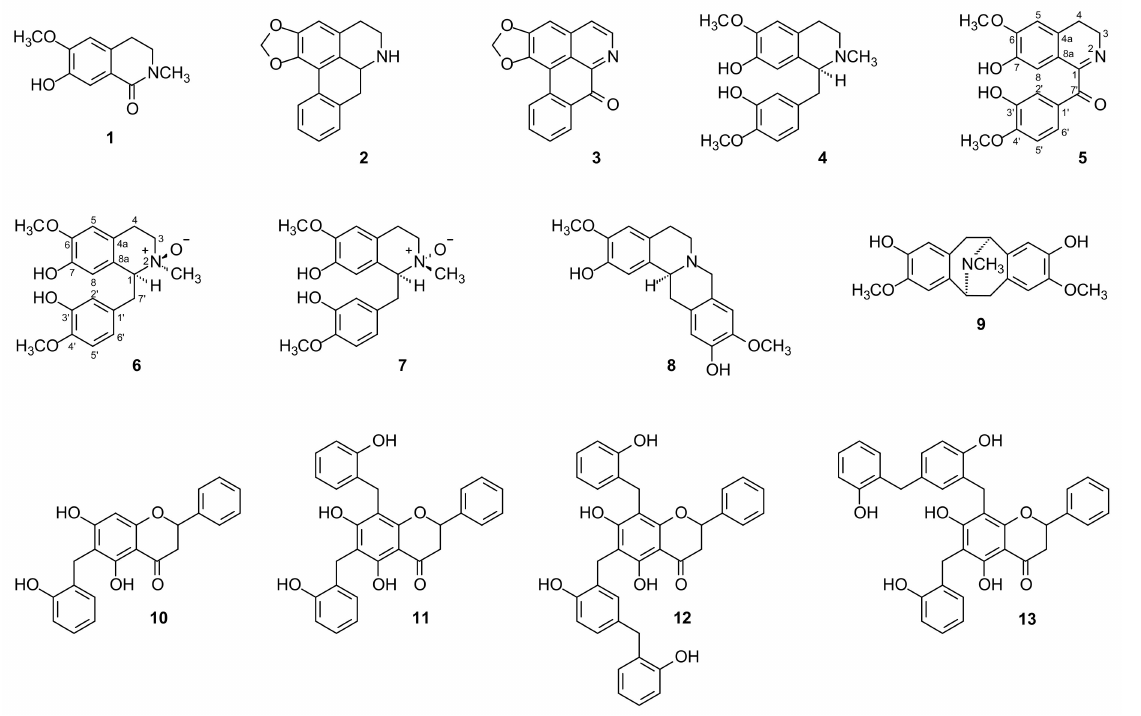
Figure 1. Chemical structures of the isolated compounds from the bark of D. calycina . Compound 5 was obtained as a brown amorphous powder and tested positive for Dragendorff’s reagent. It showed a protonated molecule at m/z 328 [M + H] + in the LR- ESI (+)MS compatible with the molecular formula C 18 H 17 NO 5 . The 1 H and 13 C-NMR spectra of 5 (Table 1) were consistent with those of reticuline ( 4 ) [27], except for the absence of the nitrogen-bonded methyl group (CH 3 − N ) and the signal of the methine group in position 1, which was replaced by a signal at δ C 165.1 in the typical 13 C-NMR spectrum of the imine group conjugated to a carbonyl group at δ C 192.8. In the 1 H-NMR spectrum, three downfield hydrogens at δ H 6.88 (1H, d, J = 8.4 Hz, H-5 (cid:48) ), δ H 7.57 (1H, d, J = 2.0 Hz, H-2 (cid:48) ) and δ H 7.60 (1H, dd, J = 8.4 and 2.0 Hz, H-6 (cid:48) ), revealed the presence of an ABX coupling system. Two singlet signals at δ H 6.90 (1H, s, H-8) and 6.71 (1H, s, H-5) indicated the presence of 1 , 2 , 4 , 5 -tetrasubstituted phenyl ring. In addition, the 1 H-NMR spectrum of 5 also showed signals for two methoxy groups resonating at δ H 3.93 (3H, s) and δ H 3.95 δ H 3.89 (2H, t, J = 7.8 Hz), attributed to H-4 and H-3, respectively (Table 1). These